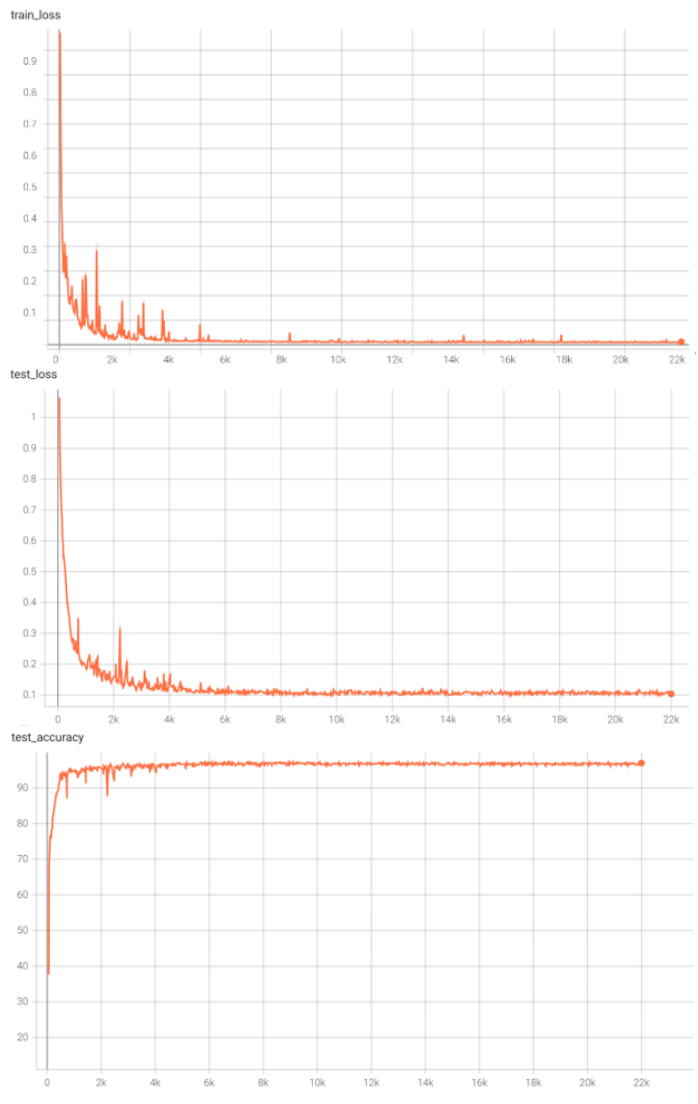
Figure 15. PointNet training curve (learning rate